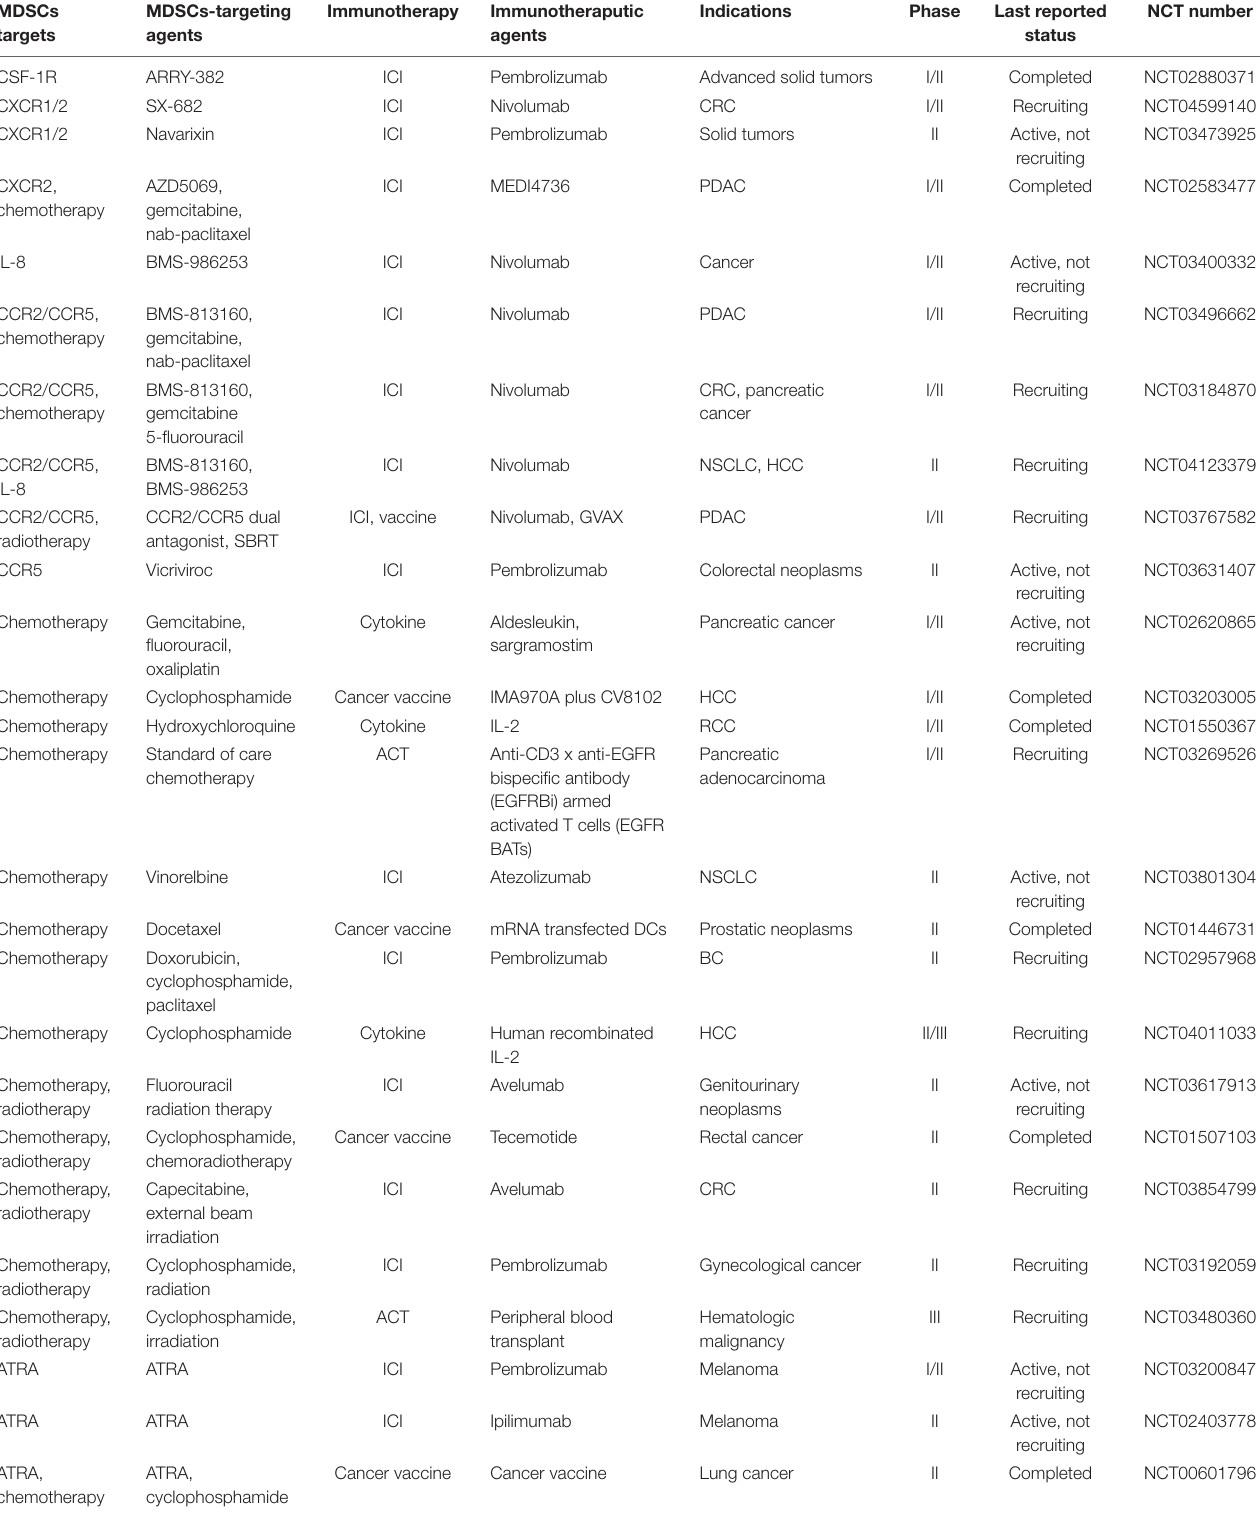
TABLE 2 | Combination strategies in clinical